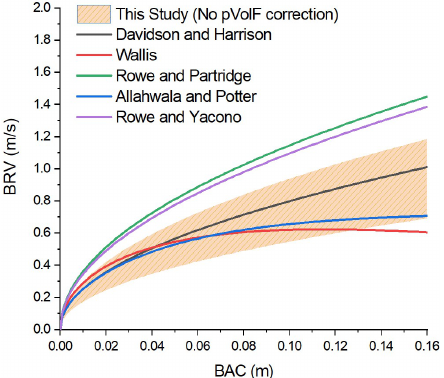
Figure 5. Probability distribution standard deviation changes with the BAC.